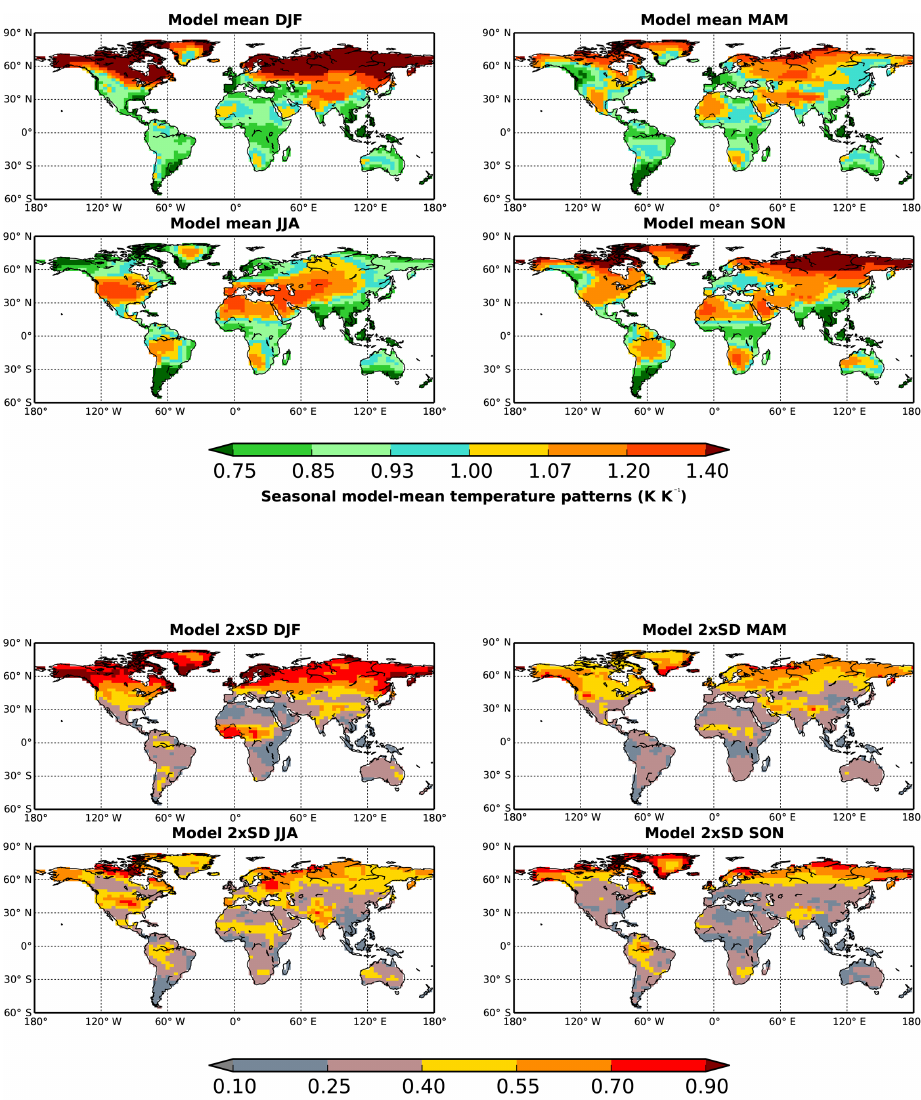
Figure 4. Seasonal means and variation (2 × SD) of the monthly patterns of local temperature change per degree warming over all land (KK − 1 ), across 22GCMs. DJF is December, January and February; MAM is March, April and May; JJA is June, July and August; and SON is September, October and